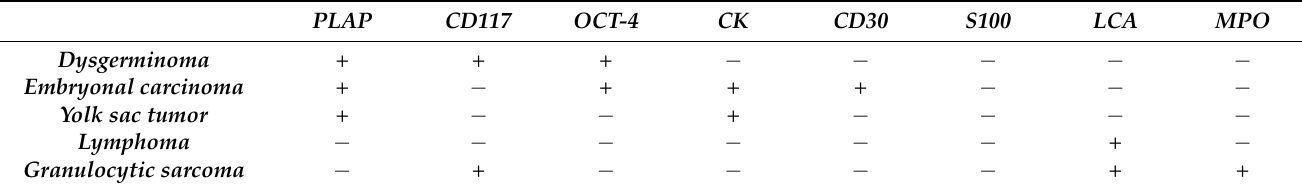
Table 5. Differential immunohistochemical diagnoses of dysgerminoma